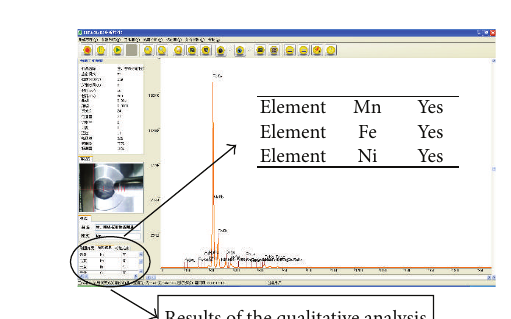
Figure 10: Results of the quantitative analysis. Table 3: Mn content of cast iron.